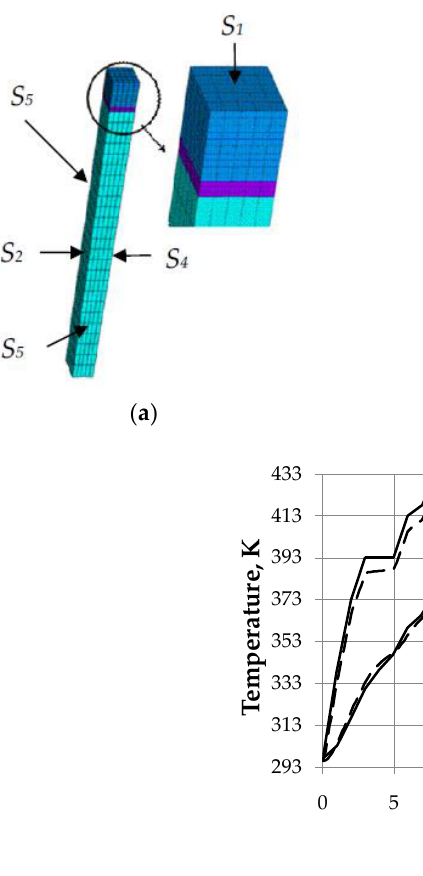
Figure 5. Convergence of the generalized relaxation curve and calculated relaxation curves. Thin lines—calculated relaxation function curves; bold lines—original relaxation function curves. ( a ) Finite element analogue with boundaries specification; ( b ) dependence of the pressure on the surface of the mandrel at the end of the winding on the number of nodal unknowns; ( c ) temperature versus time at separate points: 1 — ambient temperature, 2 — calculated temperature on the surface of the shell, 3 — real temperature on the surface of the mandrel, 4 — calculated temperature on the surface of the mandrel.